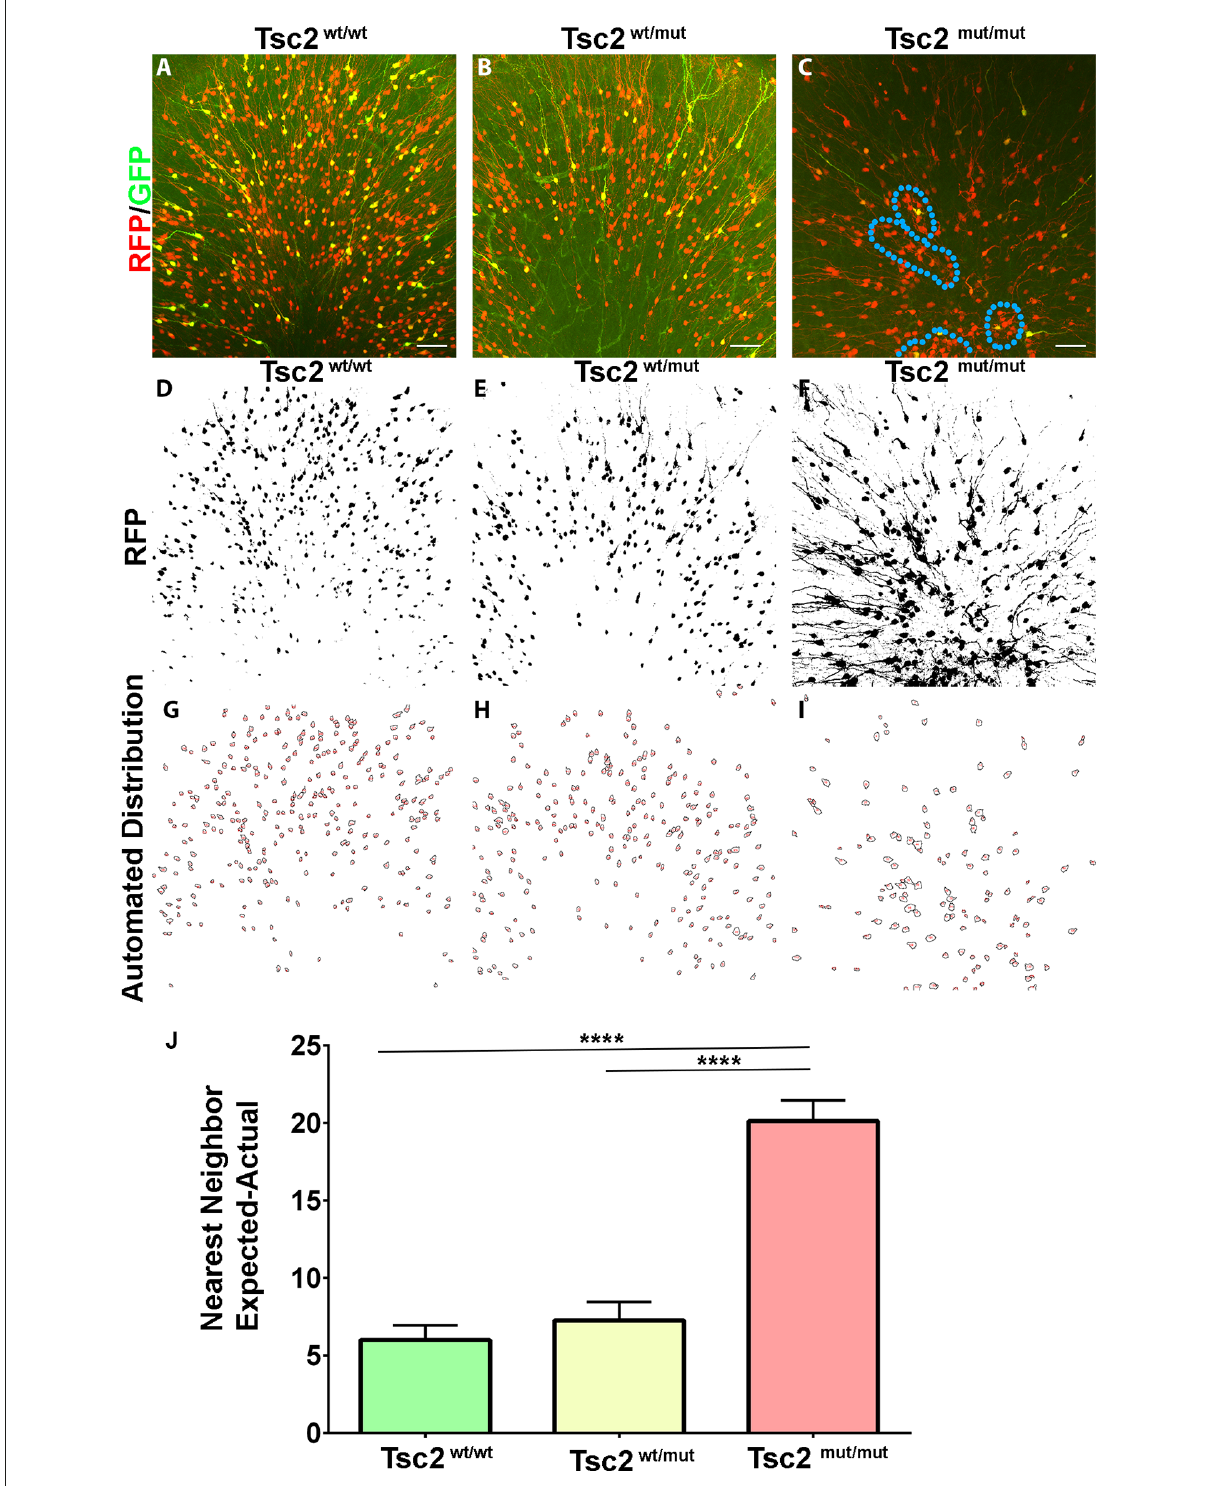
FIGURE3 OB GC organization following loss of Tsc2. (A–C) 20 × confocal images of coronal sections of OB GCs labeled with GFP (green) demonstrating recombination and expression of RFP (red), and pS6 staining (blue). (D–F) Z projections of RFP and automated thresholding. (G–I) Automated drawing of GC somas. (J) Quantification of GC organization based on expected nearest neighbor calculations in relation to actual calculations. Blue dotted line outlines clusters of ectopic cytomegalic neurons. **** p <